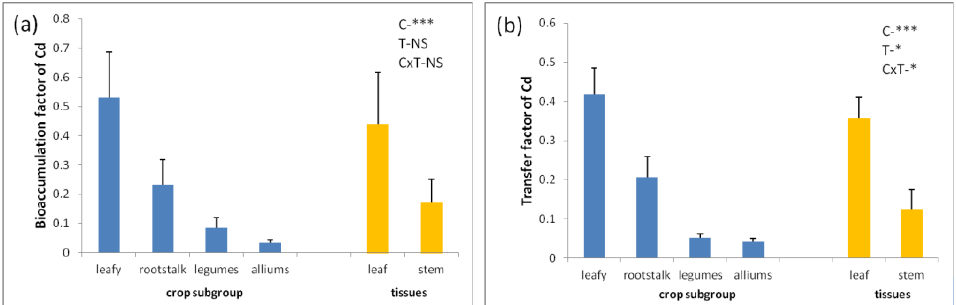
Figure 4. ( a ) Bioaccumulation factor (BF) and ( b ) transfer factor (TF) of Cd in vegetable subgroups and edible parts (Mean ± SE, DW). A two-way ANOVA was performed using as fixed factor crop subgroup (C), and tissues (T). The p -values of the two-way ANOVA for the effects of C, T and their interaction (C × T) on BF were ***, NS and NS, separately, and on TF were ***, * and *, respectively. *, p ≤ 0.05; ***, p ≤ 0.001; NS, not